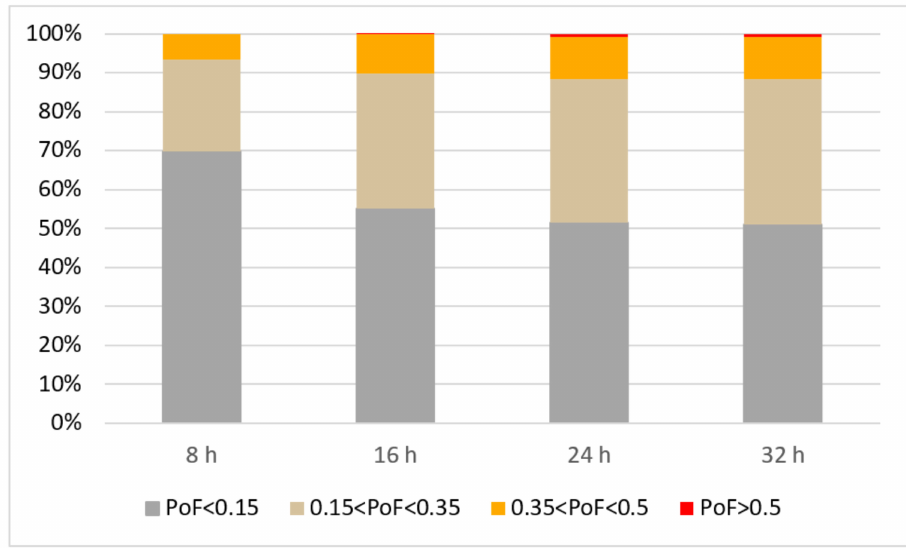
Figure 7. Number of cells in each PoF u class for different time instants td of the rainfall event. To promote a quantitative comparison between two approaches, the quantity: